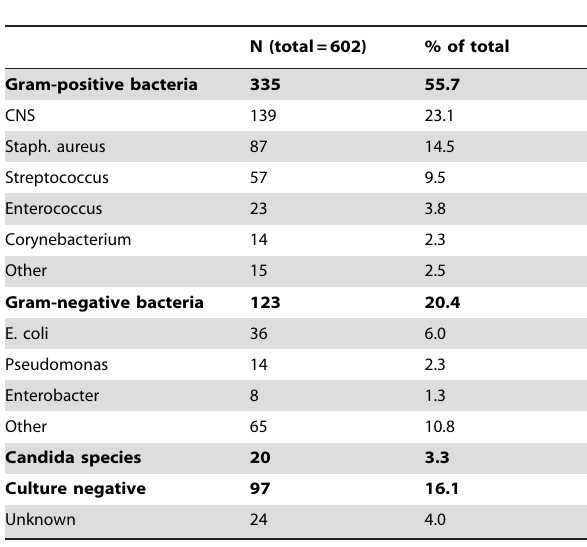
Table 2. Distribution of identified microorganisms.